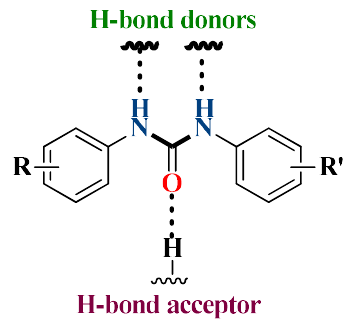
Figure 2. H-bond acceptor and donors within the diaryl urea scaffold.